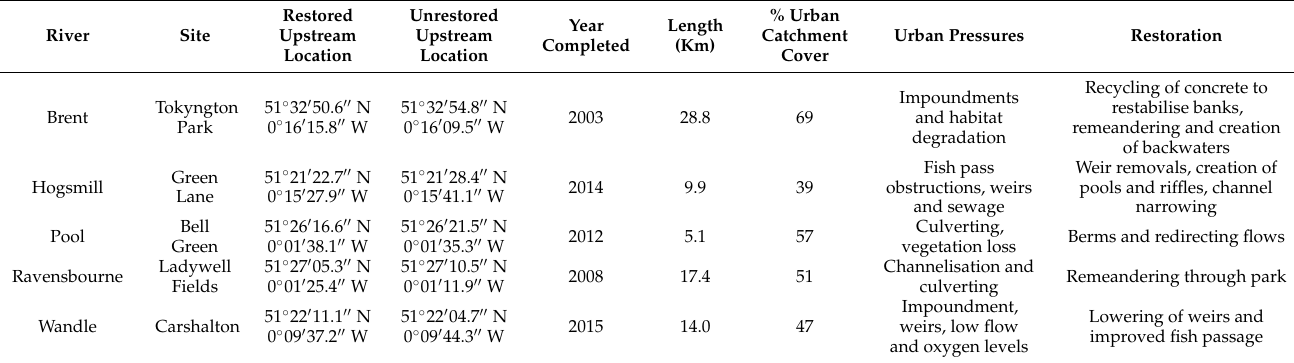
Figure 1. Locations of study rivers across the Greater London area. Bold lines denote study rivers; fine lines denote other watercourses within the wider River Thames network. Table 1 . Characteristics of restoration among the study rivers, including the upstream location of restored and unrestored reaches (degrees, minutes, seconds for latitude and longitude), year of restoration completion, total river length and % of urban catchment cover [38,39,41,42].